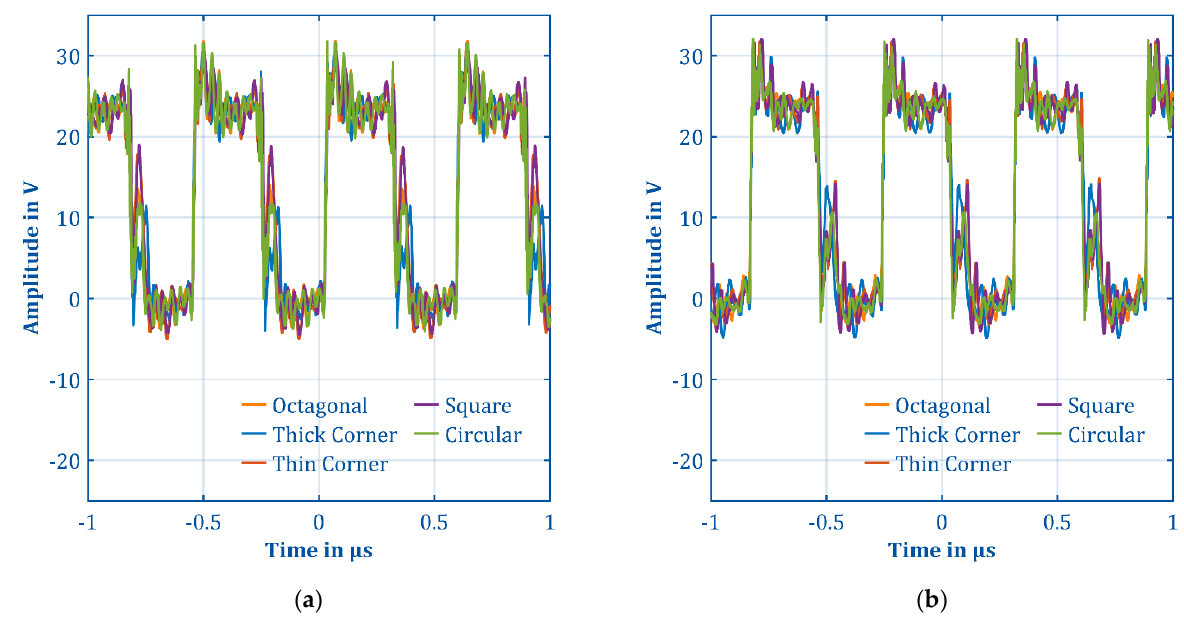
Figure A7a,b show the voltage signals at the primary winding of the transformers at 1.75 MHz.